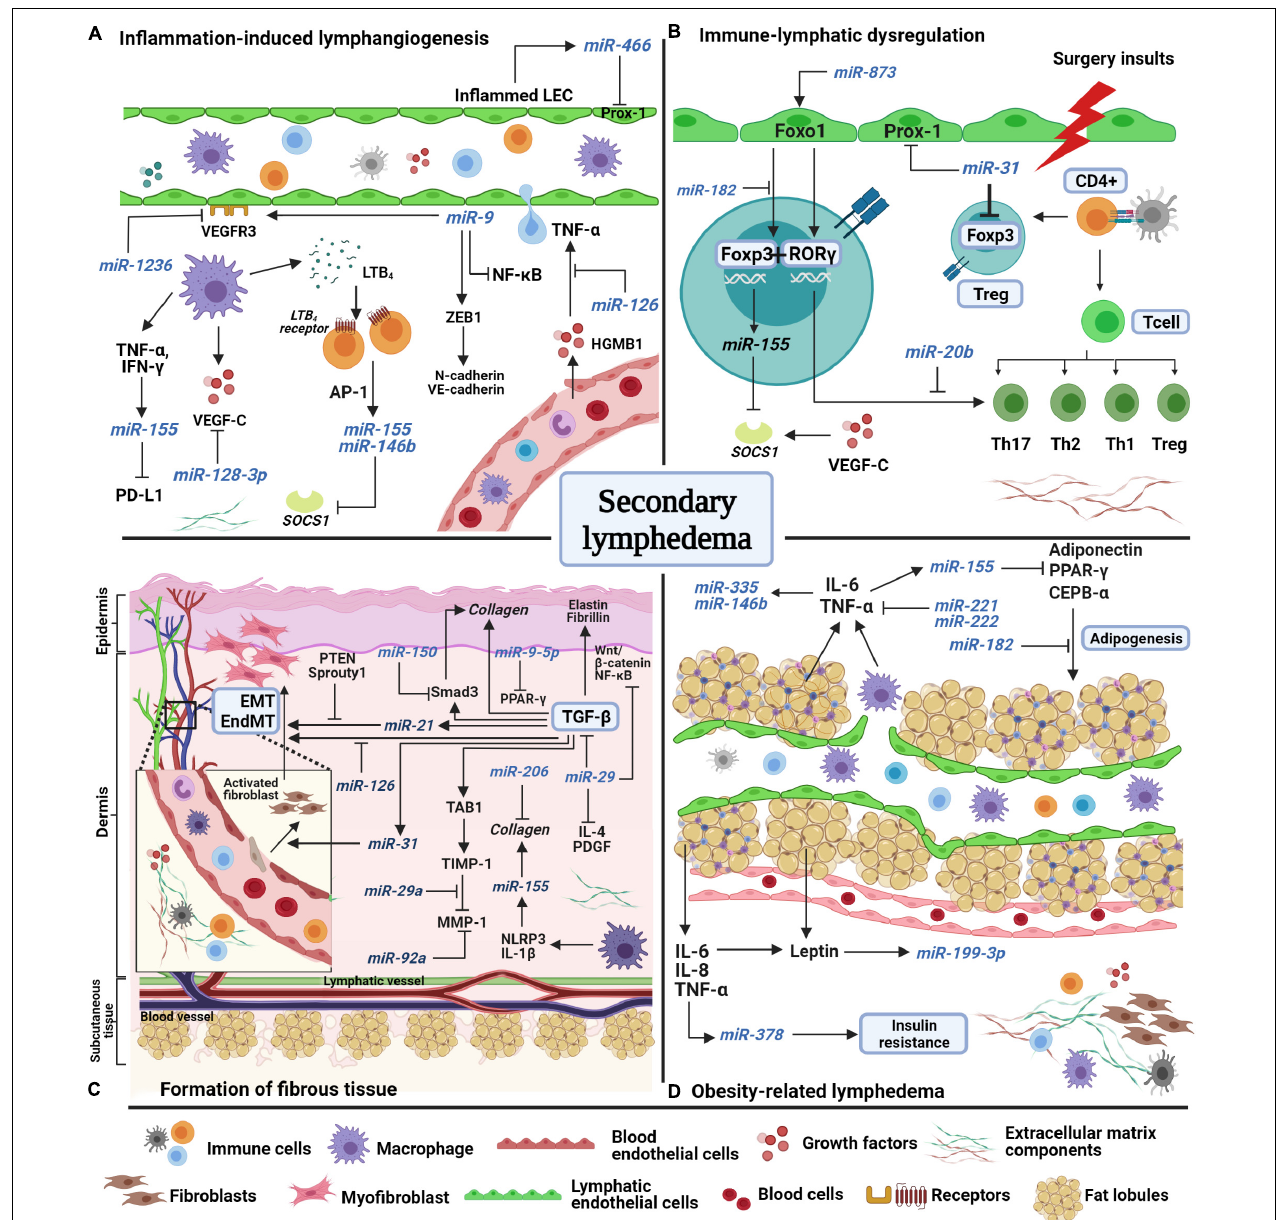
FIGURE 1 | A schematic model of miRNAs’ potential involvement in the pathological features of secondary lymphedema. (A) Inflammation-induced lymphangiogenesis involves the release of inflammatory factors from both lymphatic and blood endothelial cells. Lymphatic markers, VEGF-C and VEGFR-3 are negatively regulated by miR-1236, miR-128-3p, and miR-9. miR-466, miR-155, and miR-146b are expressed during inflammation to induce lymphangiogenesis. (B) Surgery insults to lymphatic vessels and lymph nodes induces abnormal immune regulation as immune cells are trafficked in lymphatic vessels. Due to the disruption of lymph flow, immune cells accumulate in the extracellular matrix (ECM) and start to proliferate and differentiate into regulatory (Treg) and T helper cells, which produce inflammatory factors. Unlike miR-155, miR-31 and miR-182 negatively regulate Foxp3 expression to suppress Treg cell differentiation. Foxo1 induces Foxp3 and Ror γ expression, but the interaction is halted by miR-182 and miR-20b. (C) The formation of fibrous tissue of the skin occurs over time as ECM components increase excessively in the dermis and subcutaneous layers. The main factor of fibrosis, transforming growth factor-beta (TGF- β ), mediates collagen fiber production, fibroblast differentiation, and endothelial and epithelial-mesenchymal transformation (EndMT/EMT) by directly regulating pro-fibrotic factors (TAB1, Smad3) and pro-fibrotic miRNAs such as mir-31, miR-21, and miR-155. MiRNAs such as miR-29a, miR-150, miR-9-5p, miR-126, and miR-92 act as anti-fibrotic miRNAs by suppressing the expression of fibrotic factors in multiple signaling pathways. (D) Obesity increases the risk of secondary lymphedema due to excessive accumulation of fat lobules that compress the lymphatic vessels, resulting in disruption of lymph flow. Adipokines and inflammatory factors induce the expression of miR-378, miR-199a-3p, miR-221, miR-222, miR-146b, and miR-335 which facilitate insulin resistance and fat expansion. Several miRNAs act to combat adipogenesis, such as miR-155 and miR-182. AP-1, activating protein-1; CCAAT-enhancer binding protein alpha, CEPB- α ; chemokine C-C motif ligand-21, CCL21; cluster of differentiation 4 cells, CD4 +; regulatory T cell, Treg; endothelial-mesenchymal transformation, EndMT; epithelial-mesenchymal transformation, EMT; forkhead box